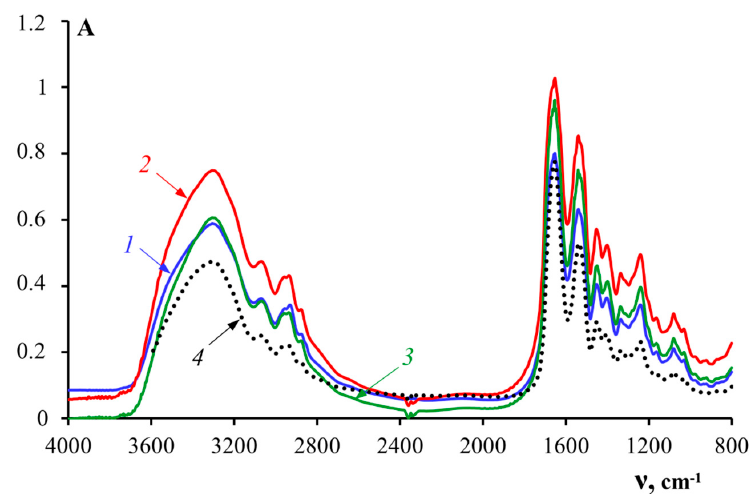
Figure 2. FTIR spectra of gelatin samples: 1—G1, 2—G2, 3—G3, 4—G 7041. Table 6. Contents (%) of major components of the secondary structure of gelatin samples.